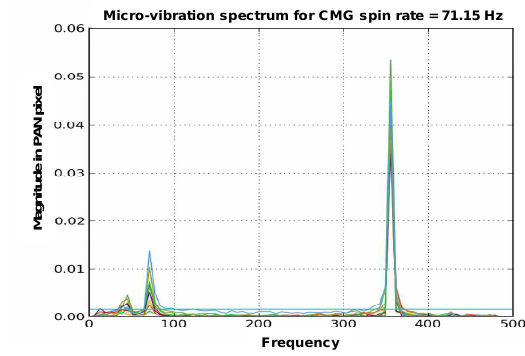
Figure 18 : starAcq method micro-vibrations measurement